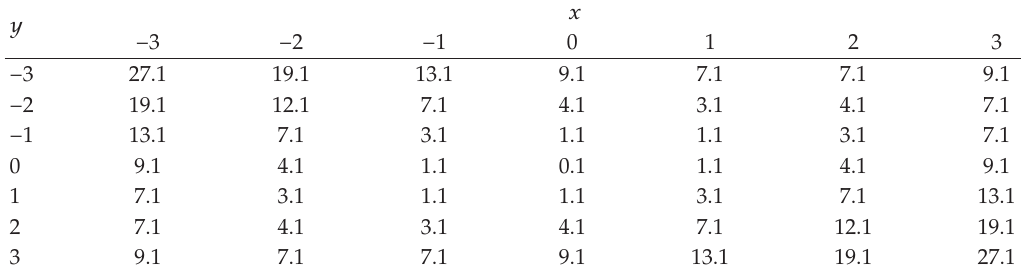
Table 3: A 3D positive data set.